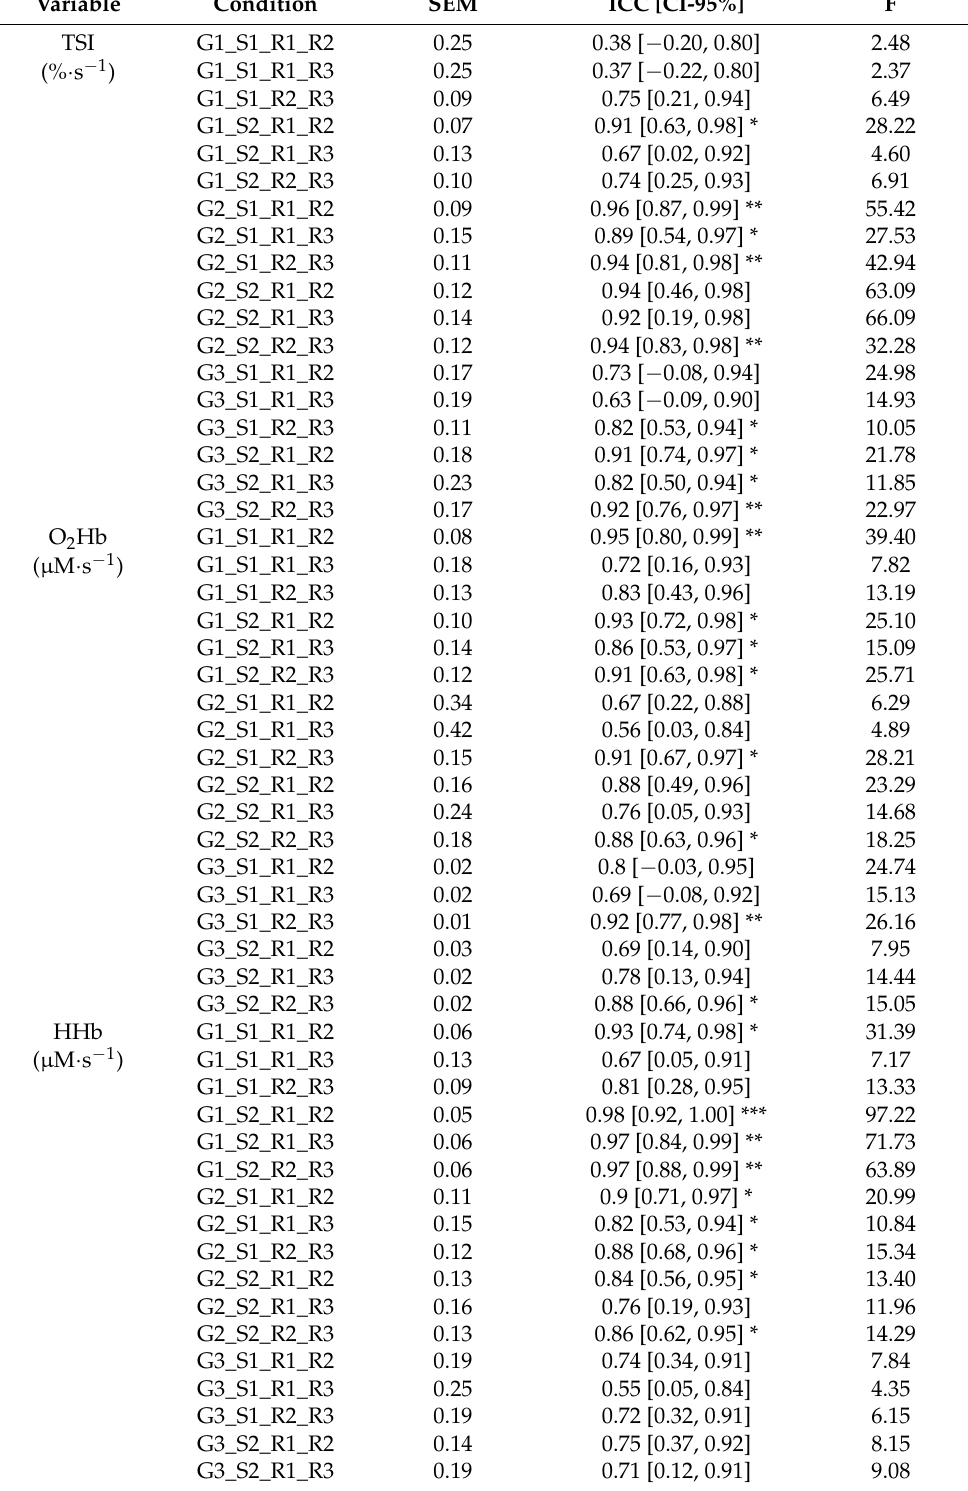
Table 7. Within-participant reliability for slope of